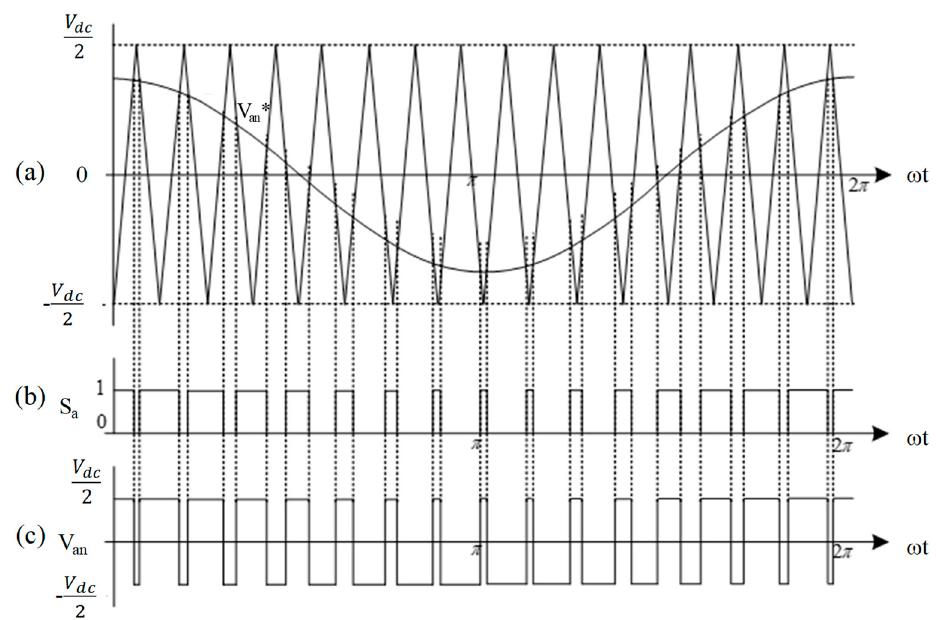
Figure 1. SPWM technique for phase a of a motor ( a ) reference phase voltage and triangular carrier wave; ( b ) switching state; ( c ) output voltage of the inverter.